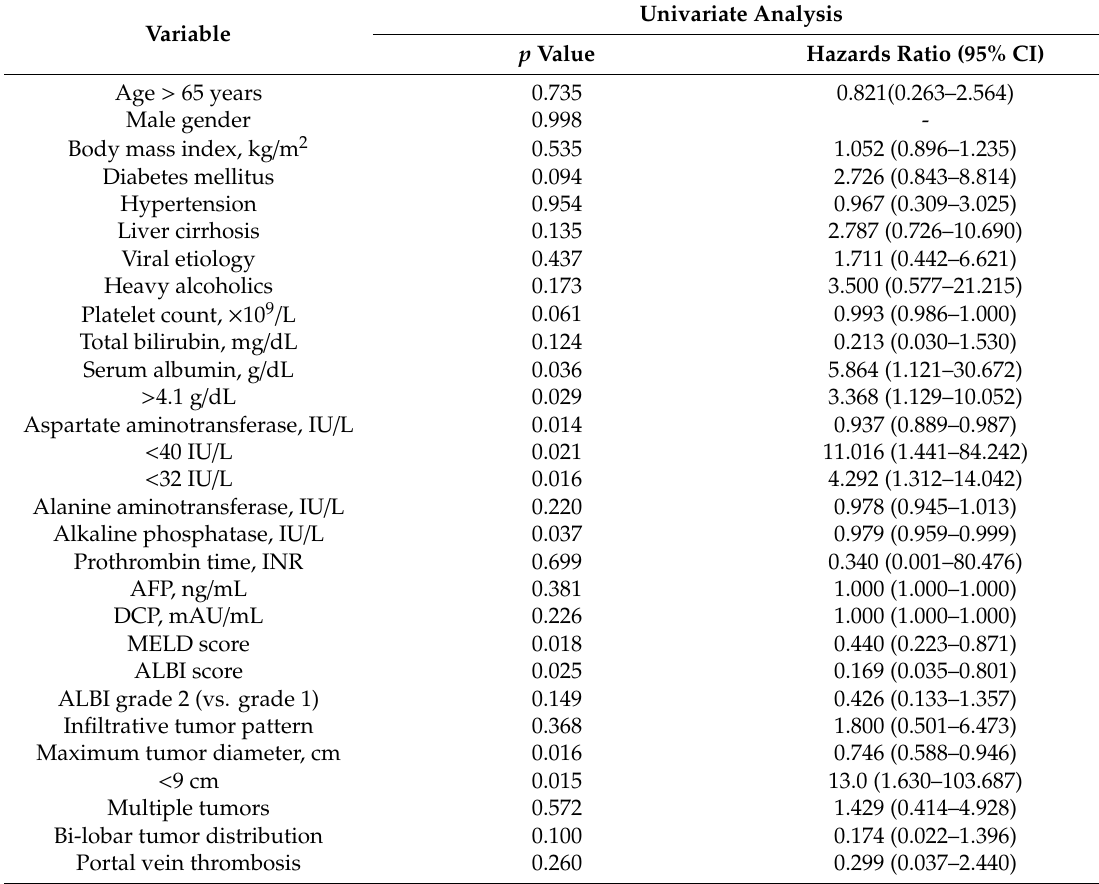
Table A1. Univariate Cox-regression analysis to predict